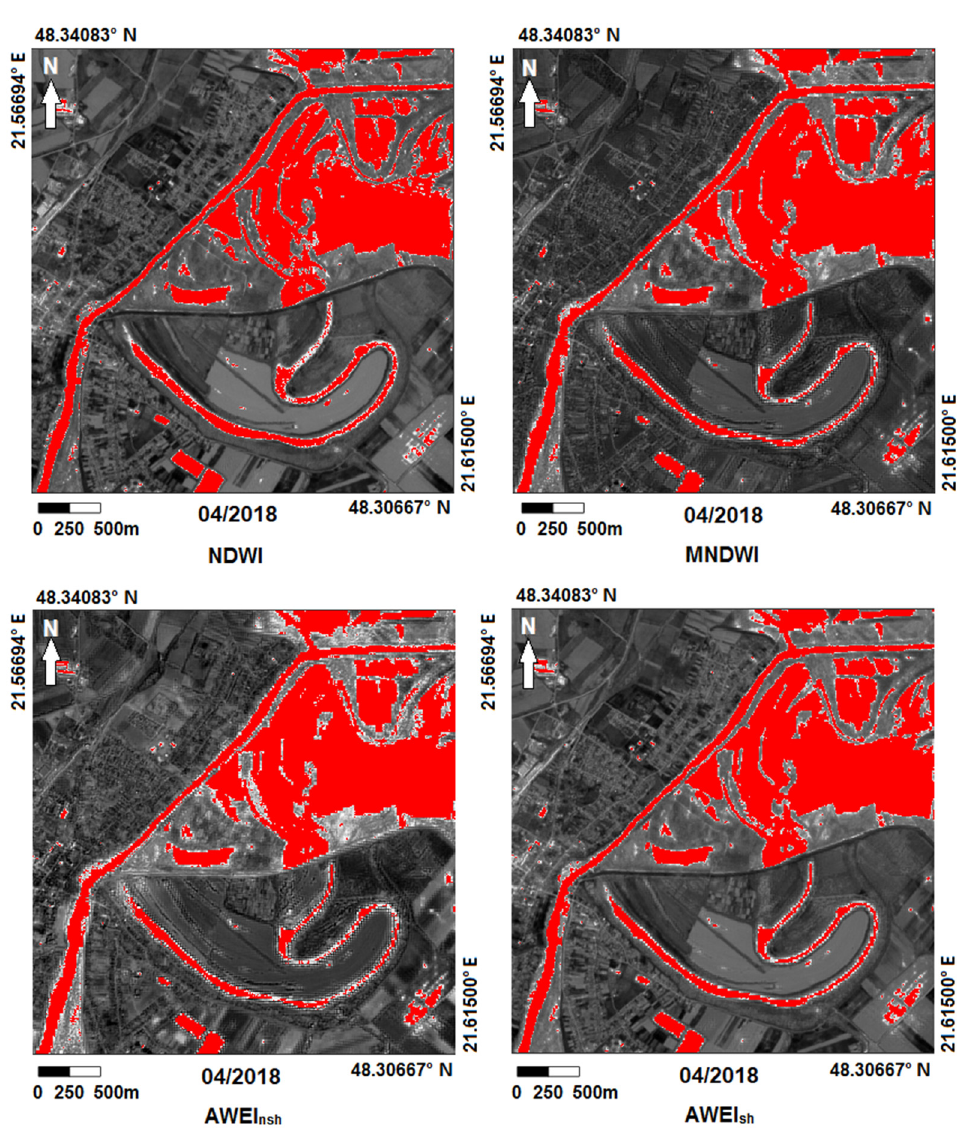
Figure 11. Comparison of water extraction results using NDWI, MNDWI AWEI nsh , and AWEI sh water spectral indices.